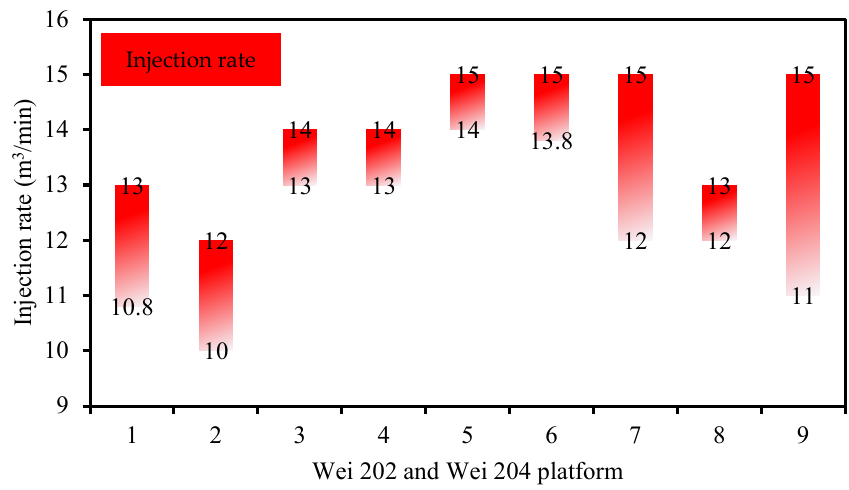
Figure 9. Fracturing injection rates of nine casing deformation wells in the Weiyuan area.